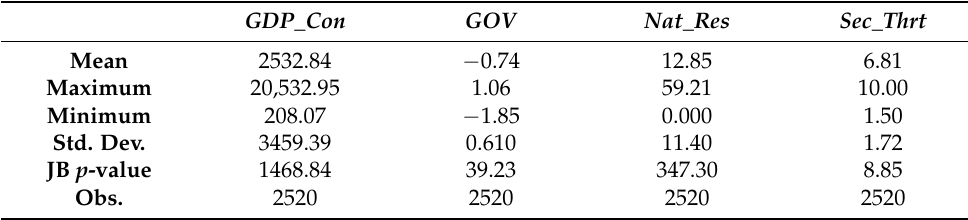
Table 1. Descriptive statistic.